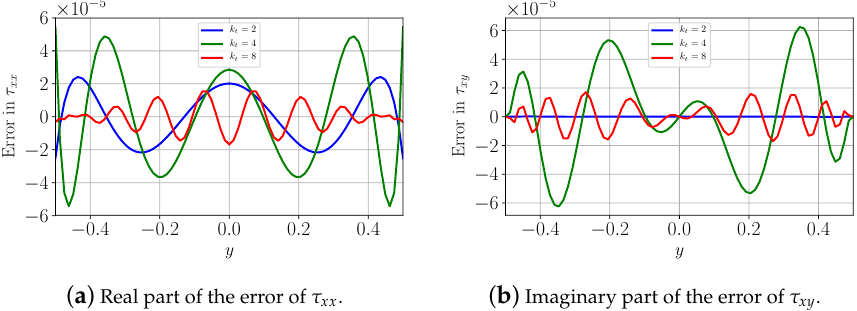
Figure 8. A set of results showing the accuracy of the zero traction boundary condition for a variety of frequencies k t for fixed Poisson ratio ν = 0.3. The maximum values of the incoming field for both tractions are order one. There is one propagating mode apiece for k t = 2 and 4, and three propagating modes when k t = 8. The number of modes in each plot was chosen to maintain the same order of magnitude accuracy: for k t = 2, N = 2 and M = 2; for k t = 4, N = 4 and M = 4; and for k t = 8, N = 10 and M =